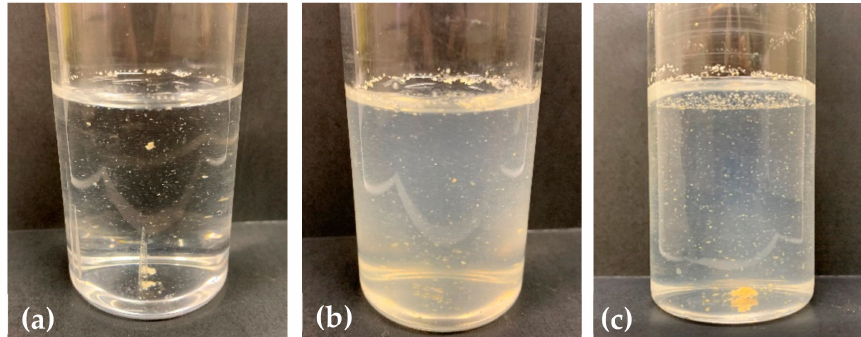
Figure 3. Formation of cell aggregates in liquid medium: ( a ) Consortium 112, ( b ) Pseudonocardia sp. TS06, and ( c ) Variovorax sp.